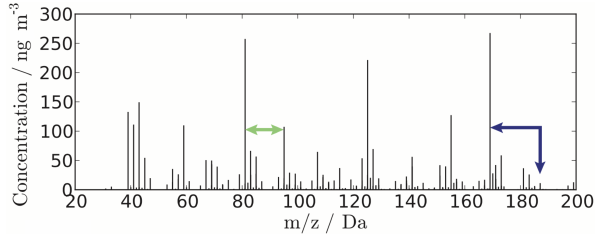
Figure 4. Mass spectrum of SOA from the dark ozonolysis of α - pinene (using cyclohexane as OH scavenger) desorbed from filter C1f at 150 ◦ C. The presence of lobes with specific periodicity is apparent. The arrows highlight two detected fragmentation patterns that cause the periodicity: that of a CH 2 group (light green arrow) and that of water (dark blue arrow); see Sect.